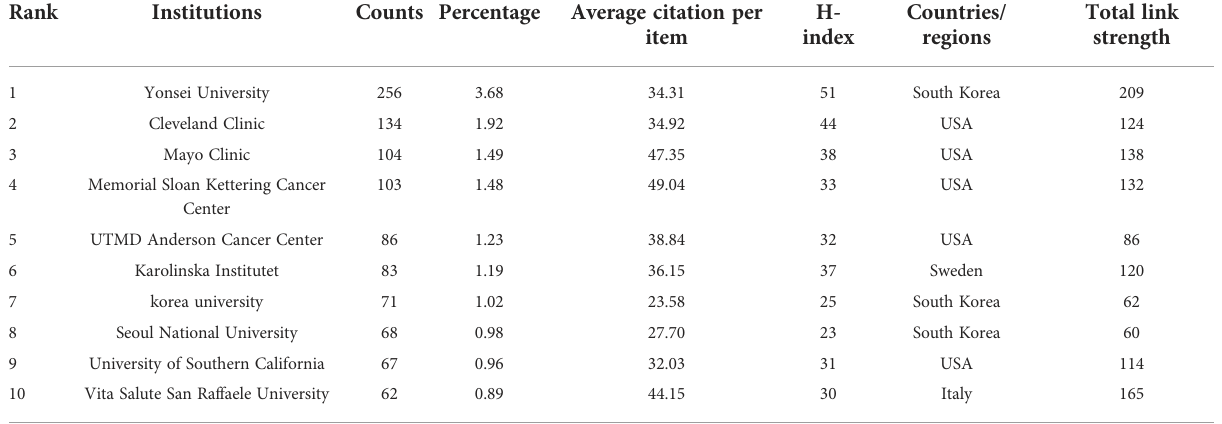
(Table 4). Among them, the Journal of Urology has close co- citation relationships with European Urology, Urology, BJU TABLE 2 The top 10 institutions for the number of publications related to oncology robotic surgery.